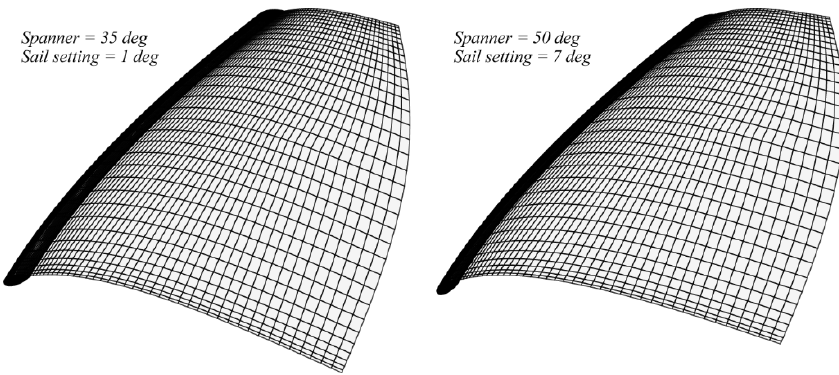
Figure 26. Comparison between two extremes of the variables design space.